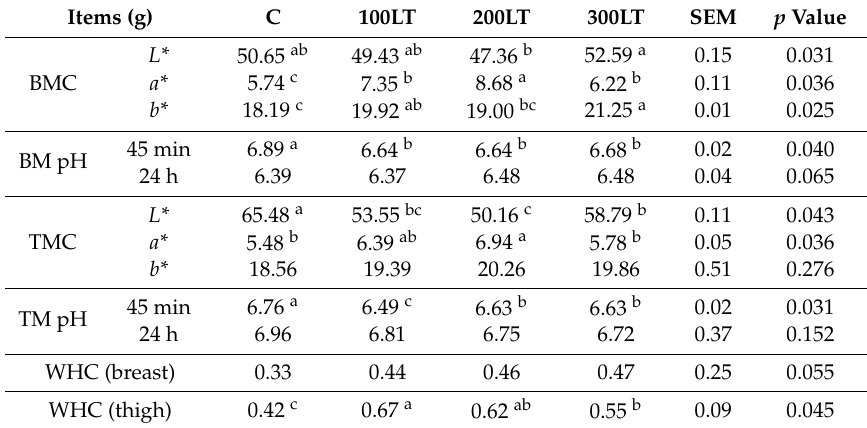
Table 3. Meat quality traits of broilers as affected by dietary L -theanine supplementation within 42 days of age.